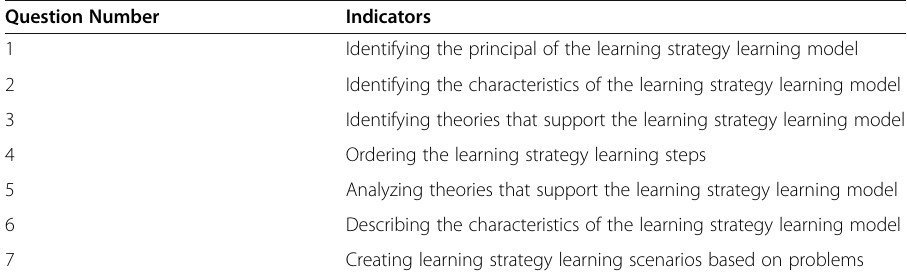
Table 4 Indicators of metacognitive questions